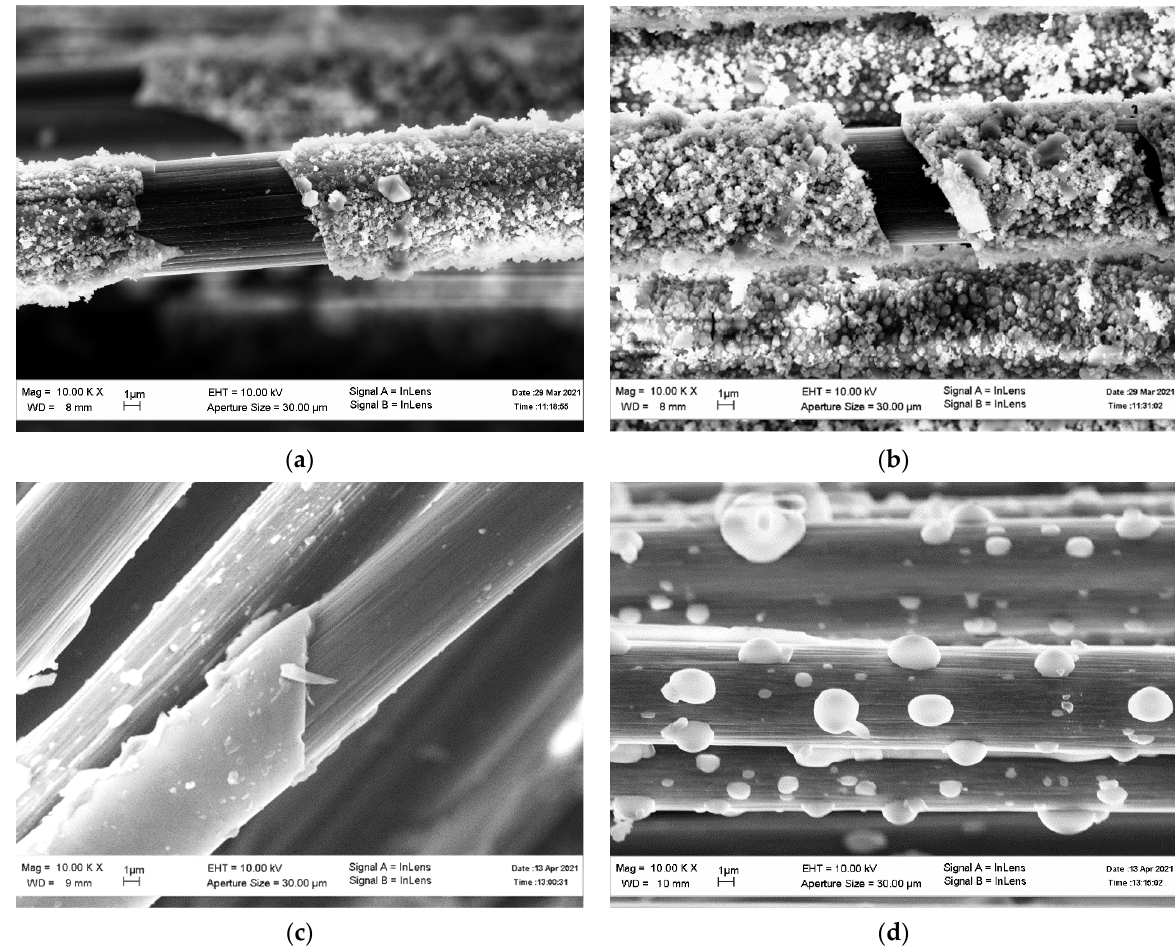
Figure 3. Coated carbon fiber in its original state ( a ) and after heating to ( b ) 570, ( c ) 870, and ( d ) 1170 °C.